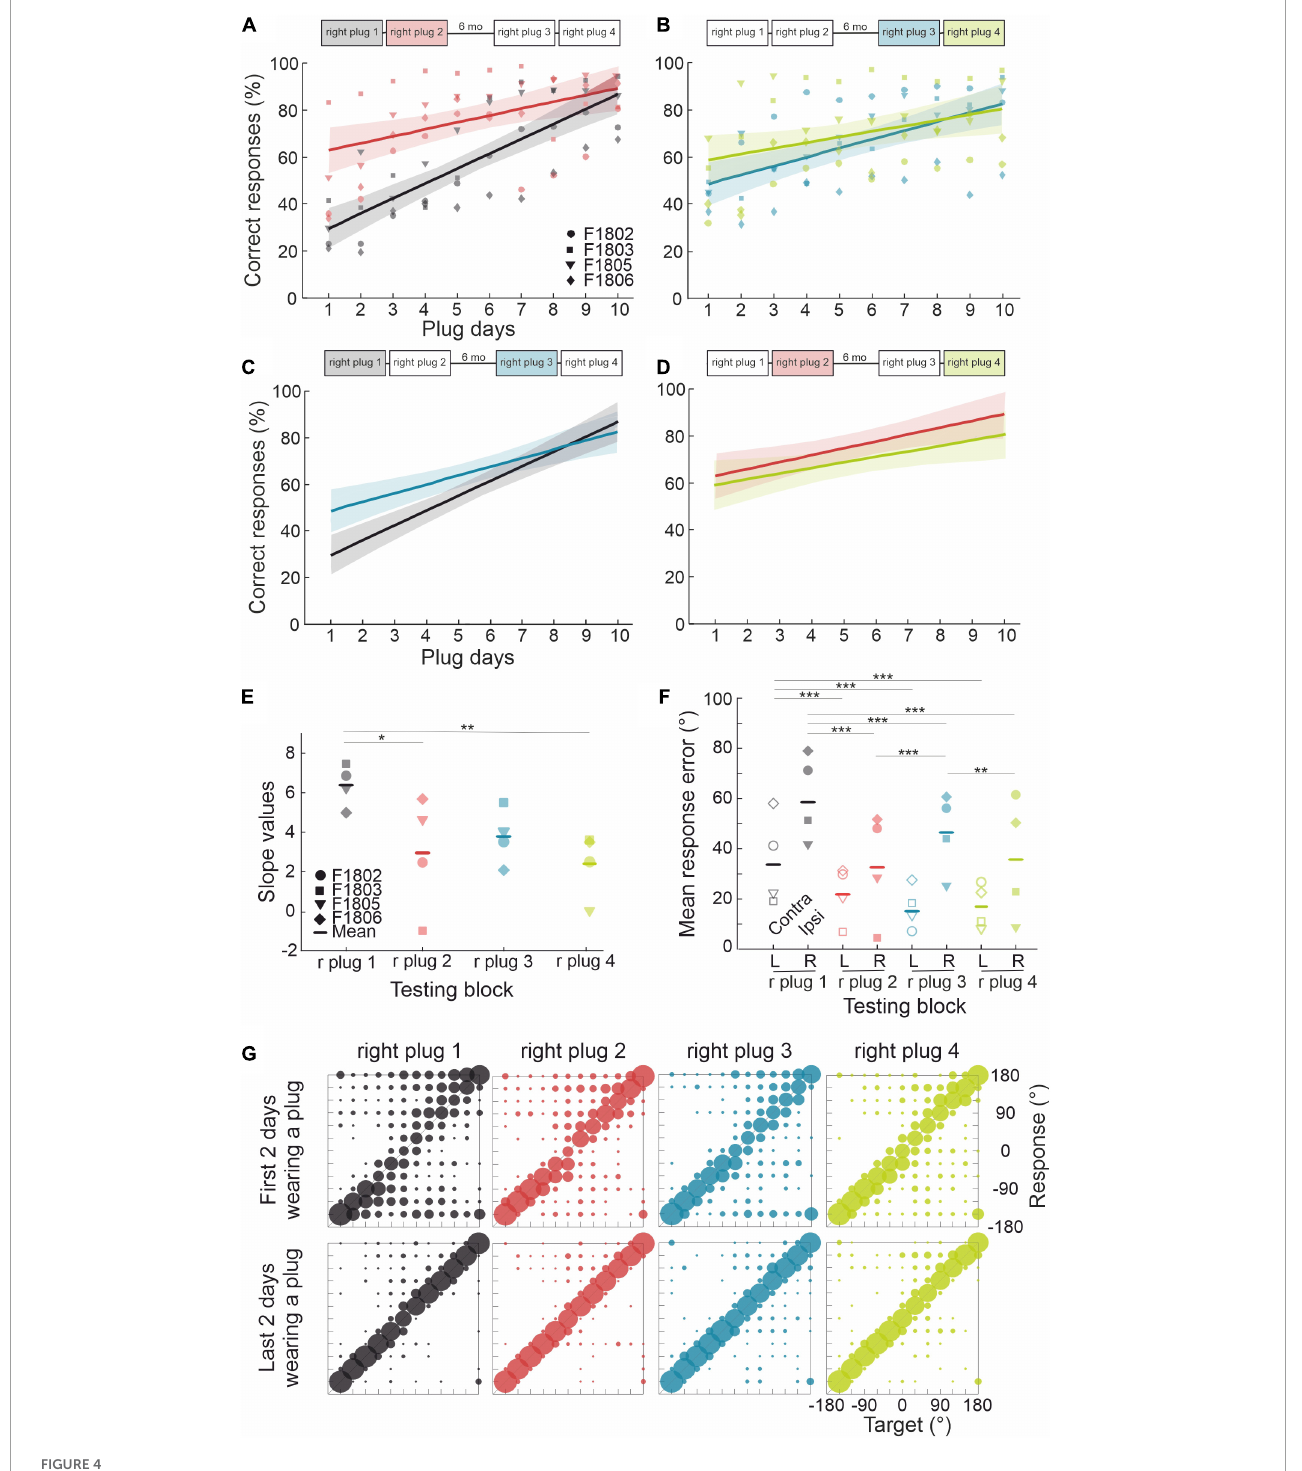
FIGURE4 Effect of repeated occlusion of the same ear on adaptive learning. (A) Regression lines (shaded areas indicate 95% confidence intervals) and individual animal scores during the first (right plug 1, black line and gray symbols) and second (right plug 2, red line and symbols) periods of right ear occlusion, which were separated by 7 days of normal binaural hearing. (B) Regression lines and individual performance for the third (right plug 3, blue line and symbols) and fourth (right plug 4, green line and symbols) periods of right ear occlusion, which were also separated by 7 days of normal binaural hearing. A longer interval of 6 months separated the right plug 2 and right plug 3 runs. (C) Comparison of regression lines for the right plug 1 and right plug 3 runs, which were each preceded by long periods ( ∼ 6 months) of normal binaural hearing. (D) Comparison of regression lines for the right plug 2 and right plug 4 runs, which were each preceded by 7 days of normal binaural hearing following the right plug 1 and right plug 3 runs, respectively. (E) Individual animal and mean regression slopes for all four periods of monaural occlusion. (F) Mean response error magnitude in the initial 2 days of each period of right ear occlusion (right plug 1 to 4). Errors are shown separately for ipsilateral (R, right) and contralateral (L, left) target locations. Midline locations (0 ◦ and 180 ◦ ) were not included in this analysis. Asterisks represent statistical significance of paired comparisons (* p < 0.05, ** p < 0.01, and *** p < 0.001). (G) Response probabilities versus target location for the initial 2 days (top row) and the final 2 days (bottom row) of each of the four periods of right ear occlusion. For the numerical values and statistical analysis, refer to the main